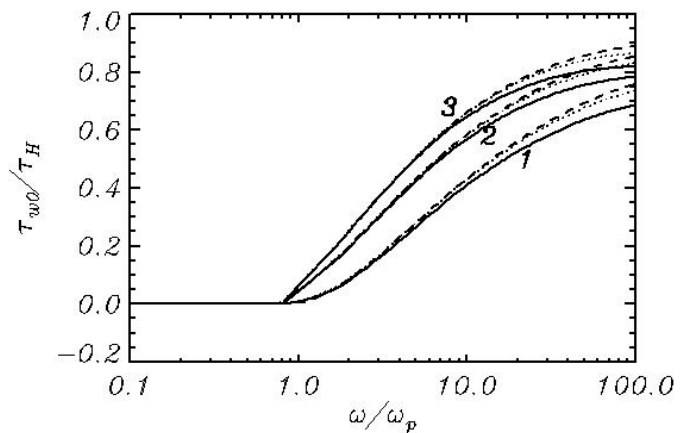
τ τ ω ω normalized by external stress H as a function of / , and p Ω = . p